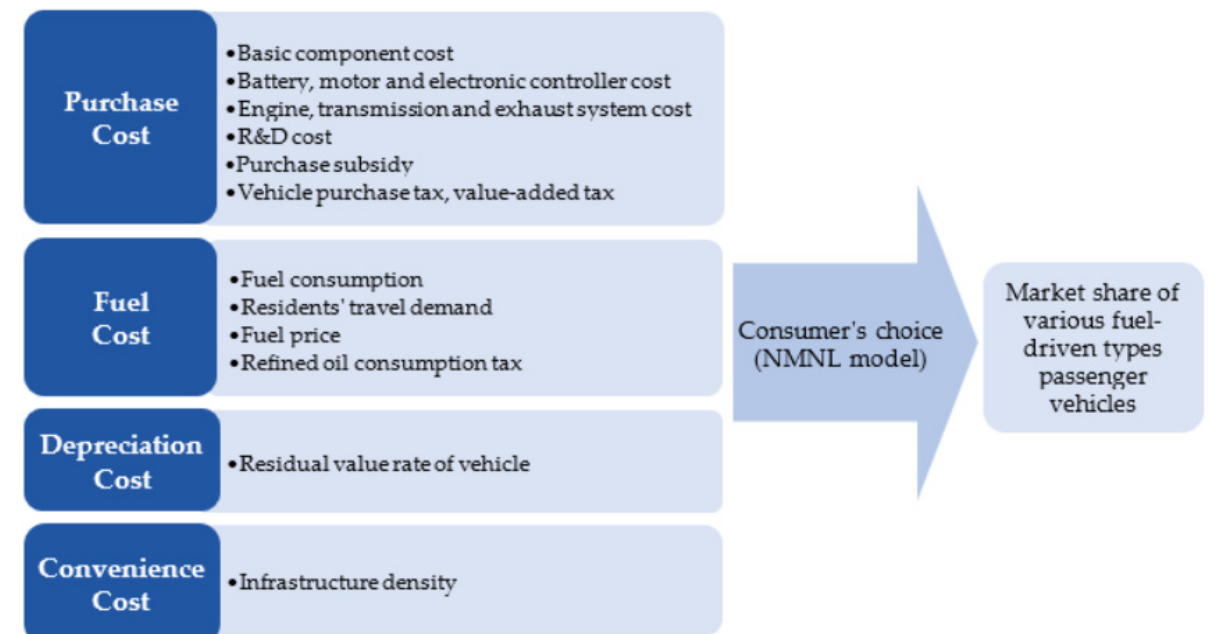
Figure 3. NMNL model flow chart. Note: The research object is A-class passenger vehicles of various fuel-driven types. For specific model examples, refer to BYD Qin Pro (ICEV/BEV/PHEV), and other fuel-driven types are also assumed to be typical A-class passenger vehicles of that fuel type.